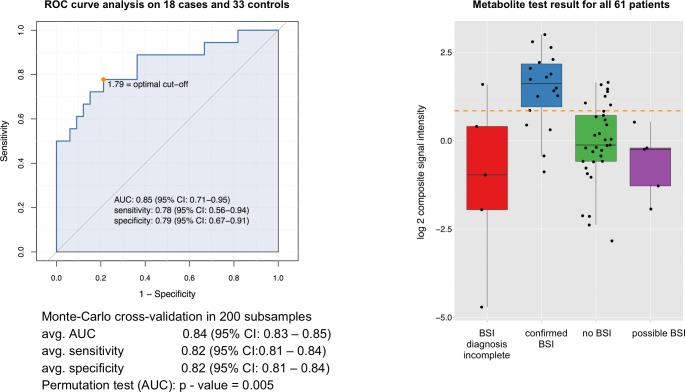
Diagnostic performance of bile metabolite signature for BSI.The metabolite signature consists of 2 bile metabolites detected by C18-UHPLC-MS: a C26 bile alcohol (ID_4741_ON, m/z M+FA-H = 483.331, putative ID: C26H46O5 27-Nor-5b-cholestane-3a,7a,12a,24,25-pentol bile alcohol) and a C27 bile acid (ID_6663_ON, m/z M+FA-H = 493.316, putative ID: C27H44O5 C27 bile acid). The figure includes: (i) a ROC curve along with the optimal cut-off value (excluding patients with BSI/malaria co-infection, incomplete or possible BSI diagnosis), (ii) check for over-fitting by Monte-Carlo cross-validation based on 200 rounds of balanced subsampling in all cases and controls and the significance permutation test, and (iii) a boxplot with the test result for all 61 patients (x-axis categories indicate the patient groups based on the study case definitions, y-axis shows the test-value of the diagnostic test which is based on the sum of the signal intensity of the two metabolites, here called composite signal intensity, included in each model, the orange dashed line indicates the cut-off value determined in the ROC analysis).